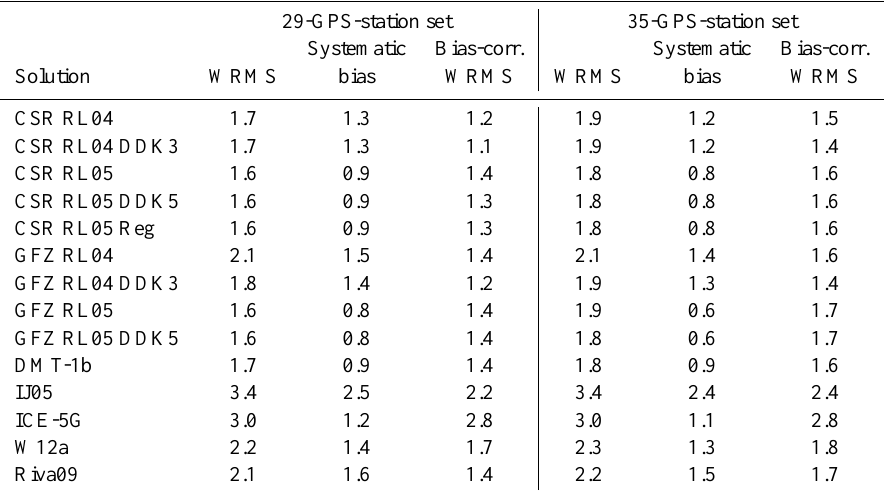
Table 4. Comparison of estimated GIA rates with GPS vertical rates, using only uncertainties for the GPS uplift rates in the WRMS calcula- tions. 29-GPS-station set 35-GPS-station set Systematic Bias-corr. Systematic Bias-corr. Solution WRMS bias WRMS WRMS bias